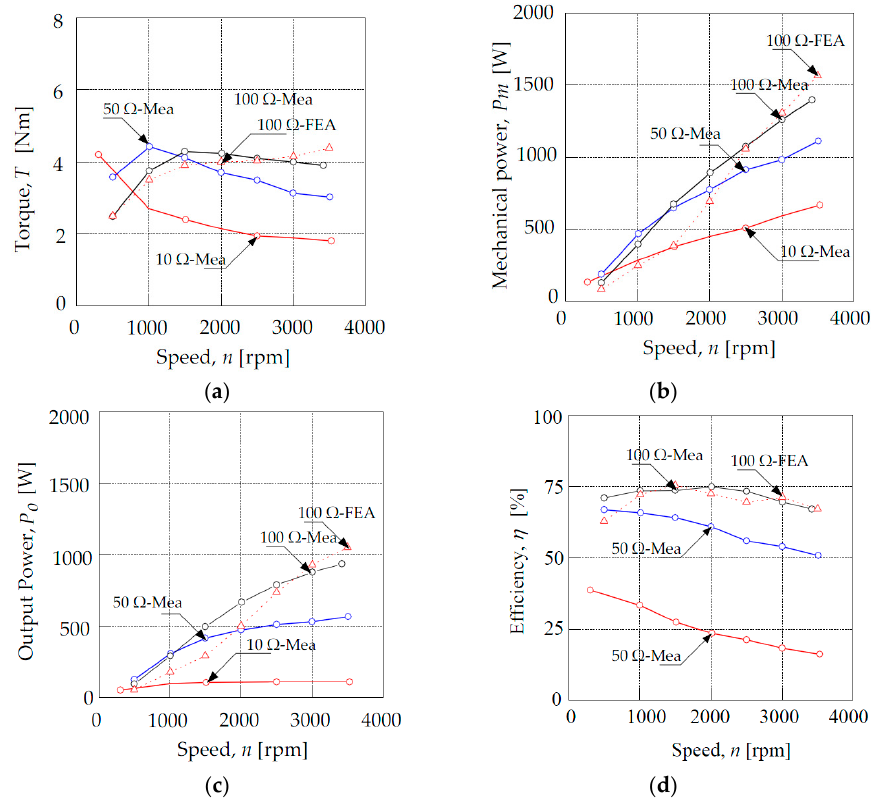
Figure 16. Performance characteristic of DSSR-PMG prototype with various loads, ( a ) Torque; ( b ) Mechanical input power; ( c ) Output power; ( d ) Efficiency.